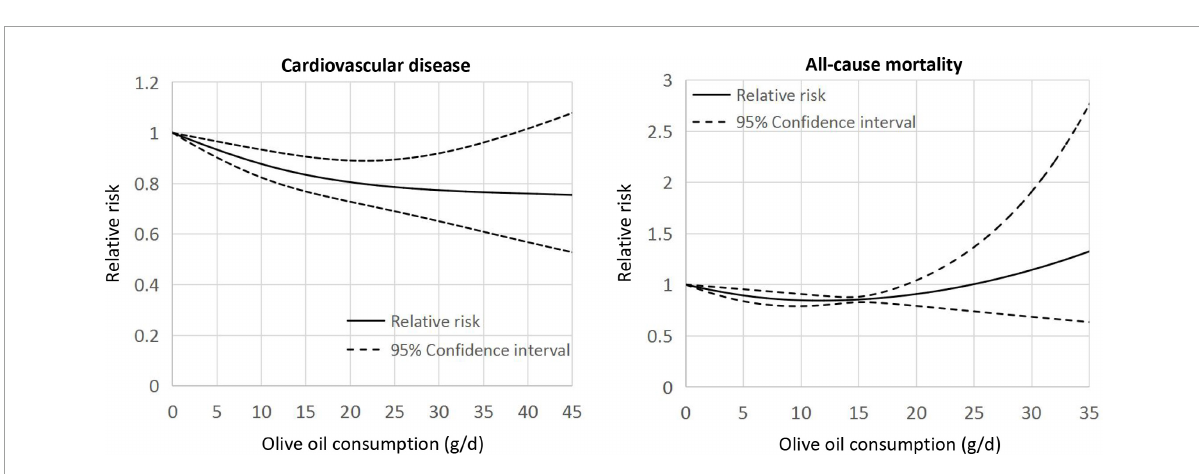
FIGURE4 Curvilinear associations of olive oil consumption with the risk of cardiovascular disease and all-cause